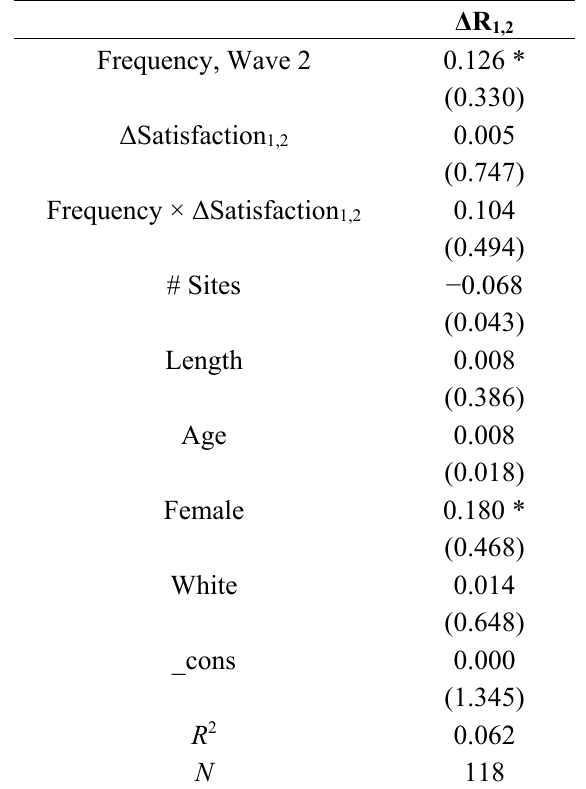
Table 8. Standardized Weighted OLS Regression Results Predicting Change in Risk